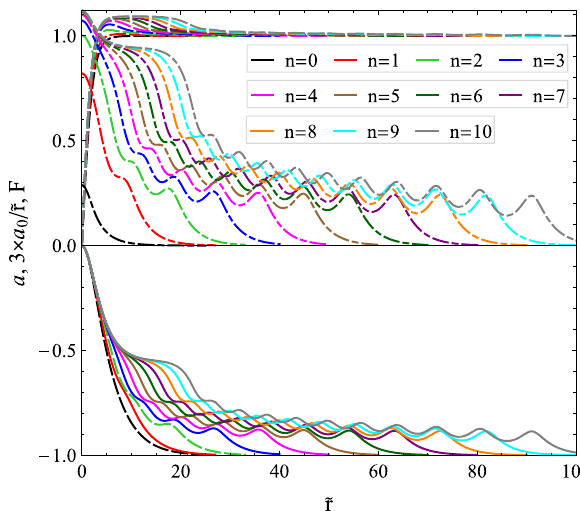
Fig. 9 Profile functions ˜ σ for the first 10 radially excited states of the vortex-Q-ball system. The curves correspond to parameters ˜ ω = 0 . 7, ˜ m = 1, ˜ g = 1, ˜ h = 0 . 2, ˜ λ = 0 . 125, ˜ v = 2, ˜ e = ˜ q = 0 . 1, N = 1, and K = 0